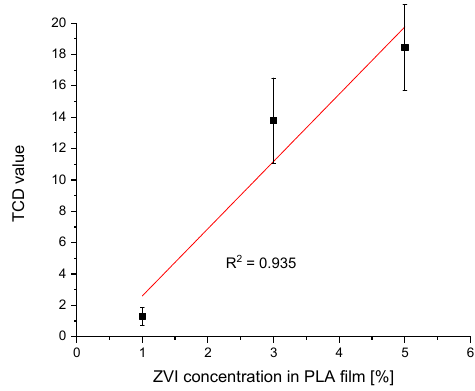
Figure 2. Total color change (TCD 2 ) values calculated in the comparison of ZVI / PLA (films with a defined concentration of ZVI) with pure PLA film—the influence of ZVI addition on the color of PLA films.